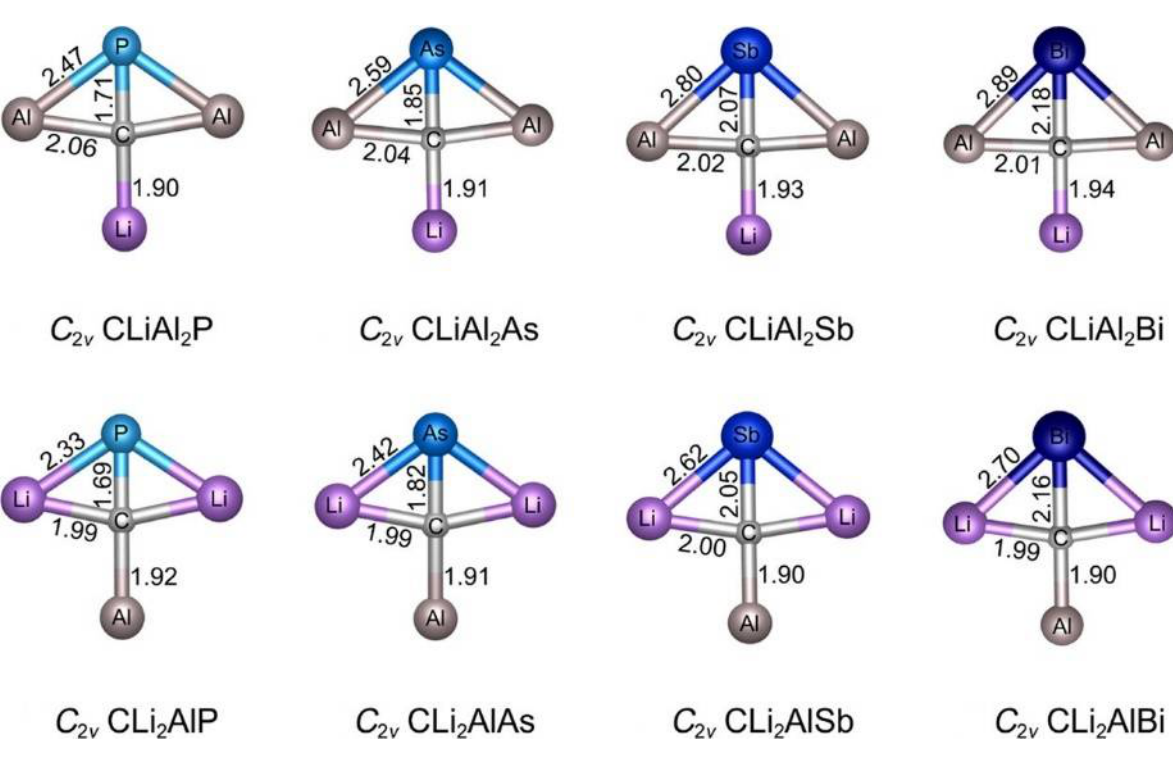
Figure 13. Optimized ptC global minimum structures of C 2 v CLiAl 2 E and CLi 2 AlE (E = P, As, Sb, Bi) at B3LYP/C, Li, Al, P, As/aug-cc-pVTZ/Sb, Bi/aug-cc-pVTZ-pp levels. Bond distances are in Å.